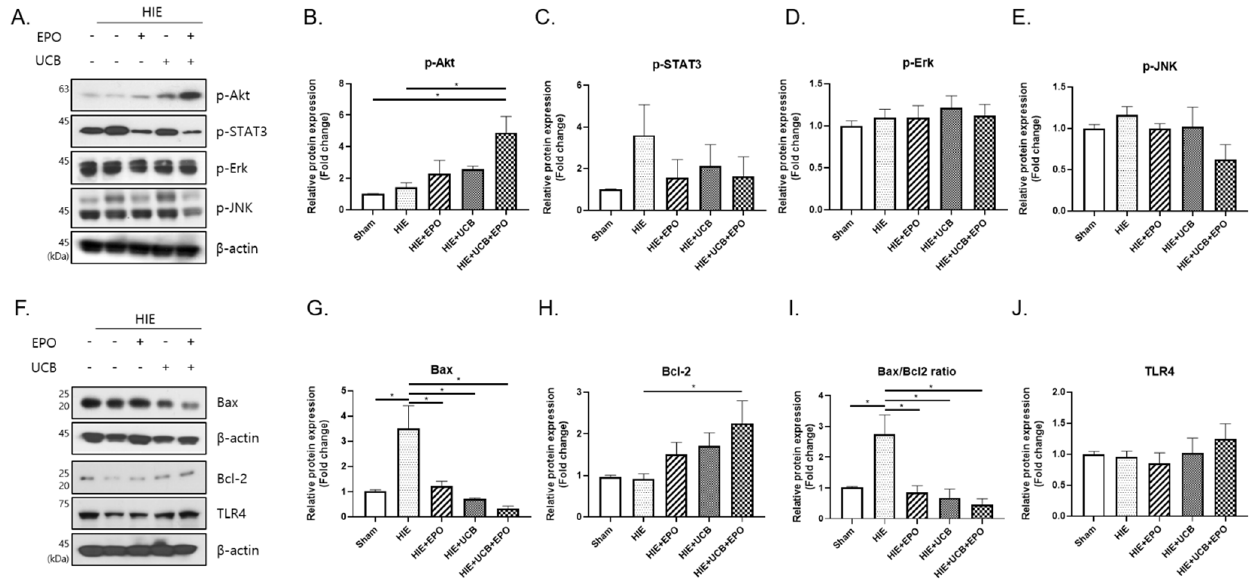
Figure 4. Each treatment group up-regulated the anti-apoptotic effect via Akt signaling. ( A ) The levels of p -Akt, p -STAT3 (S727), p -Erk and p -JNK were detected using Western blotting to observe the consecutive changes after administration. ( B – E ) The graphs depict the band intensity by the ImageJ program for the band of image A. ( F ) The levels of related apoptosis proteins (Bax and Bcl-2) and TLR4 after hUCB and rhEPO treatment. ( G , H , J ) The graphs depict the band intensity and ( I ) represents the Bax/Bcl-2 ratio. Data shown as the mean ± standard error of mean. n = 3 to 8 per group, * p < 0.05 (( B , C , J ) Kruskal–Wallis; ( D , E , G – I ) one-way ANOVA).